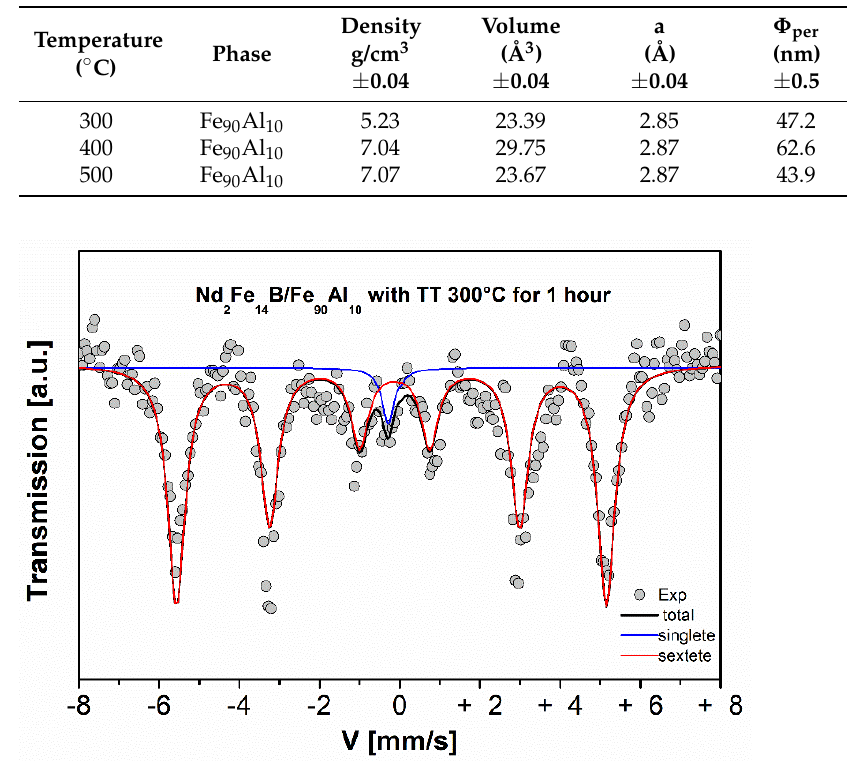
Figure 10. Mössbauer spectra of the sintered Nd 2 Fe 14 B/Fe 90 Al 10 system for one hour at 300 °C.